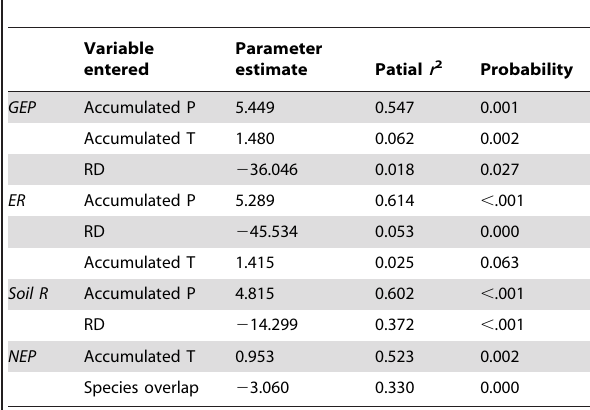
Table 1. Results of stepwise multiple regression analyses.